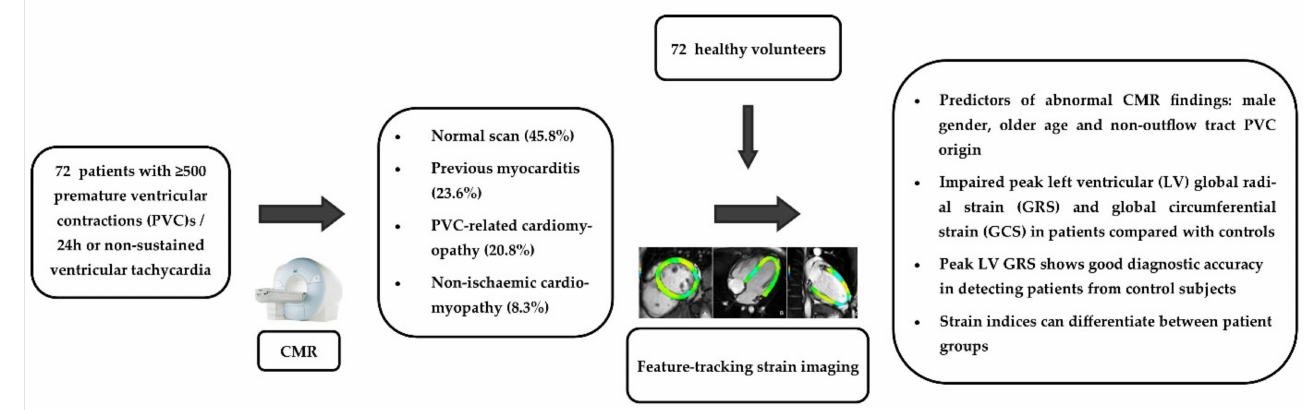
Figure 5. Graphical representation of the study protocol and the main